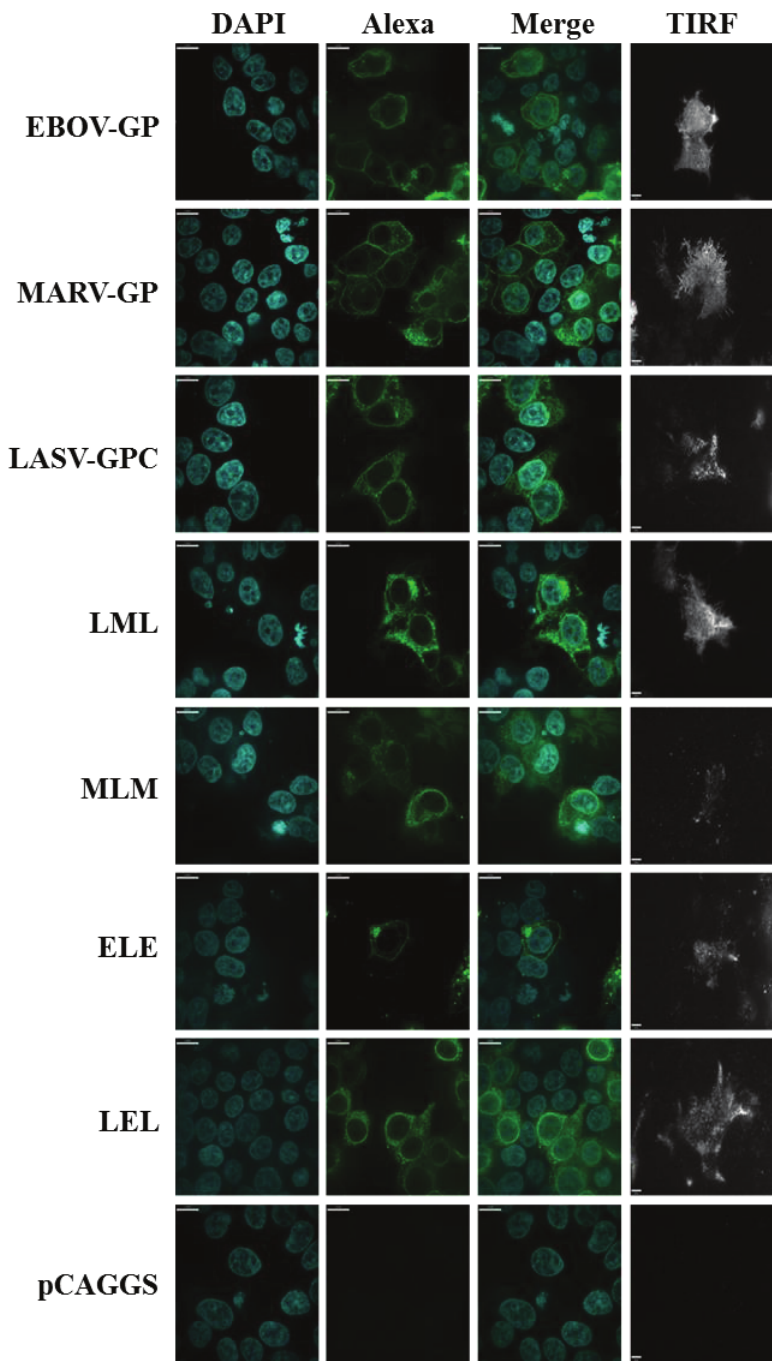
Figure 4. Cellular localization of filoviral and Lassa virus glycoproteins with exchanged transmembrane domains. The indicated glycoproteins were transiently expressed in 293T cells and GP expression was detected by staining with V5-specific antibody and Alexa Fluor 488 labeled secondary antibody. Nuclei were visualized by DAPI staining. Staining was analyzed by spinning disc microscopy. In addition, surface localized GP was detected by TIRF